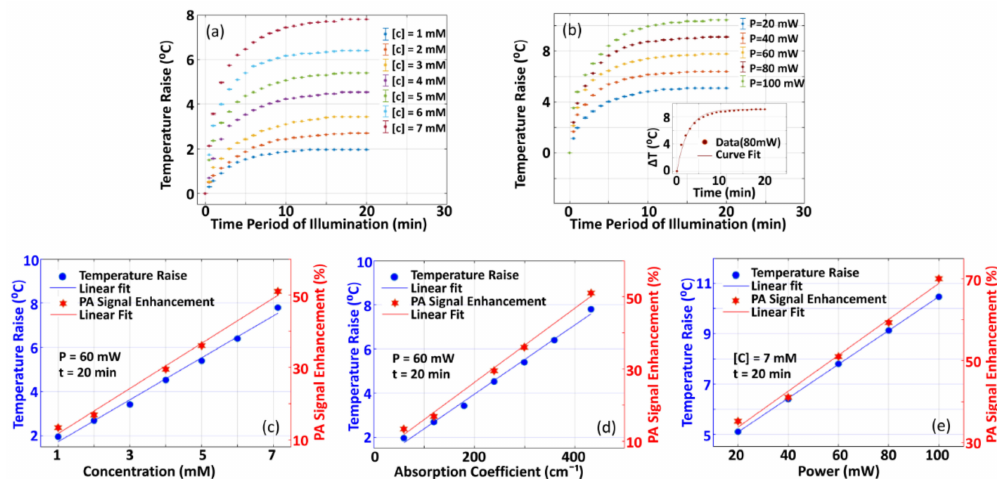
Figure 5. ( a ) Variation of temperature-raise ( ∆ T ) with respect to time-interval ( t ) of pre-illumination of CW optical beam (with concentration as experimental parameter (for P = 60 mW)). ( b ) Variation of ∆ T against t with optical power ( P ) of CW laser beam as an experimental parameter (for [ C ] = 7 mM), ( c ) Variation of ∆ T against concentration (where P = 60 mW, t = 20 min were employed), ( d ) Variation of ∆ T against optical absorption coefficient (where P = 60 mW and t = 20 min were employed), and ( e ) Variation of ∆ T against optical power of CW beam for pre-illumination (where [ C ] = 60mW and t = 20 min were